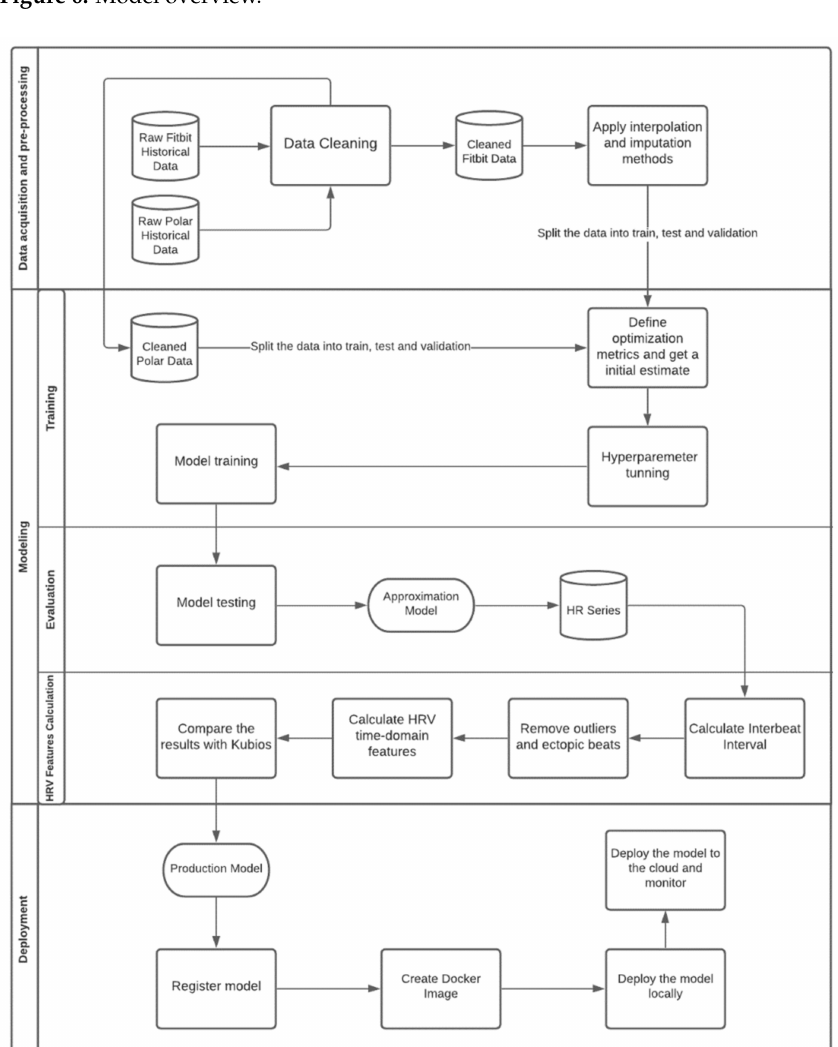
Figure 7. Development process